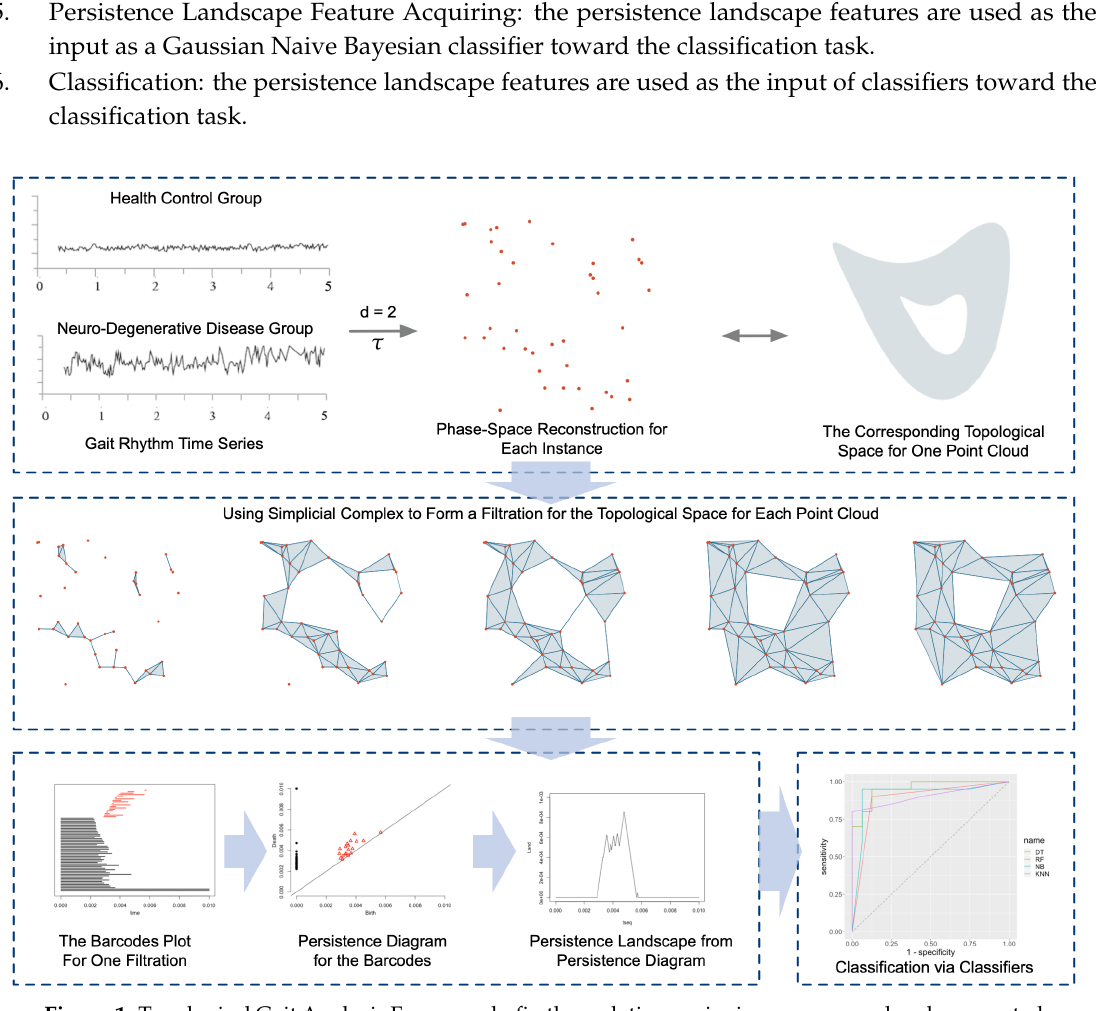
Figure 1. Topological Gait Analysis Framework: firstly, each time series is pre-processed and segmented into an equal-length time series; secondly, with time delay embedding the corresponding data point clouds are generated, each with one corresponding topological space; thirdly, the topological data analysis techniques are used to study the point clouds; finally, the topological features are extracted as a novel representation of the time series, thus used in the classification oriented machine learning framework for disease